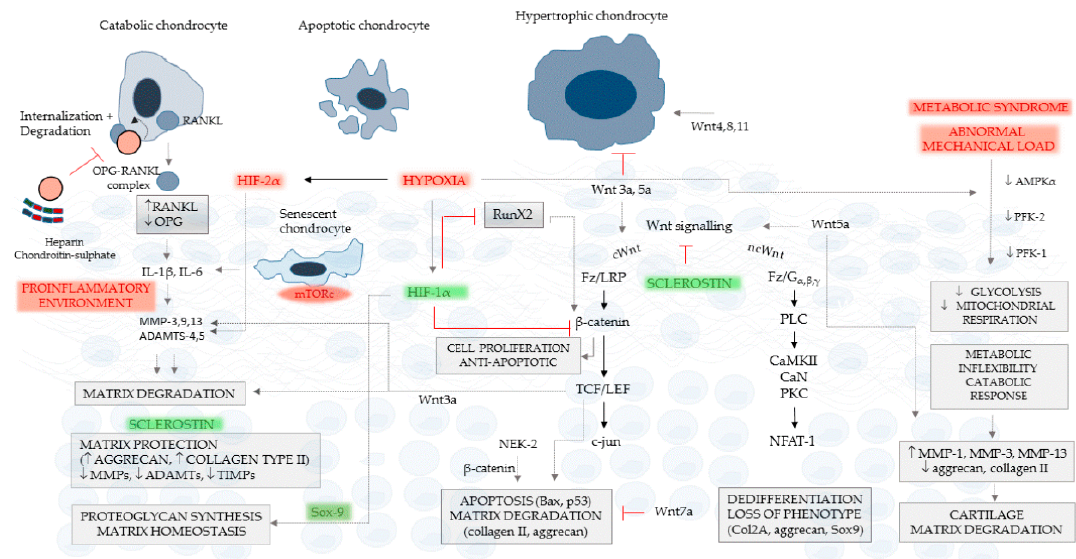
Figure 2. E ff ects of OPG / RANKL and Wnt signaling on chondrocytes and cartilage. The presence of catabolic, apoptotic and hypertrophic chondrocytes is a characteristic of osteoarthritis. Chondrocytes expressing RANKL release it in the soluble form, triggering IL-1 β and IL-6 overexpression in the cartilage. Senescent chondrocytes contribute to this pro-inflammatory environment, increasing the synthesis of MMP-3, -9 -13, ADAMTS-4 and -5. The pro-inflammatory activity results in degradation of cartilage extracellular matrix. OPG links to RANKL and facilitates its internalization with consequent degradation. Sclerostin is a strong inhibitor of cartilage degradation, which suspends MMPs, ADAMTs and even their inhibitors—tissue inhibitors of metalloproteinases—stimulating in parallel aggrecan and collagen type II production. Canonical Wnt signaling and β -catenin are anti-apoptotic and stimulate chondrocyte proliferation; however, TCF / LEF is a downstream activator of apoptosis and matrix degradation. Hypoxia, triggering HIF-1 α , generates an inhibitory e ff ect on β -catenin and RunX2 and enhances the homeostatic e ff ects of Sox-9. Non-canonical Wnt activation has di ff erent